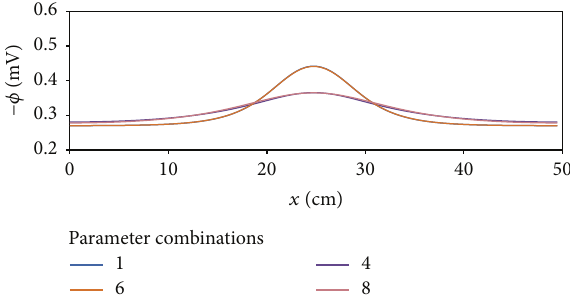
Figure 8: Electrical potential profile on concrete surface, showing that combination 1 is similar to 6 and that 4 is similar to